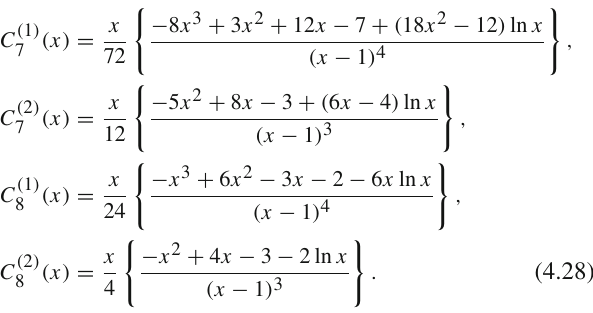
with x t ≡ ( m t / m H ± ) 2 ,